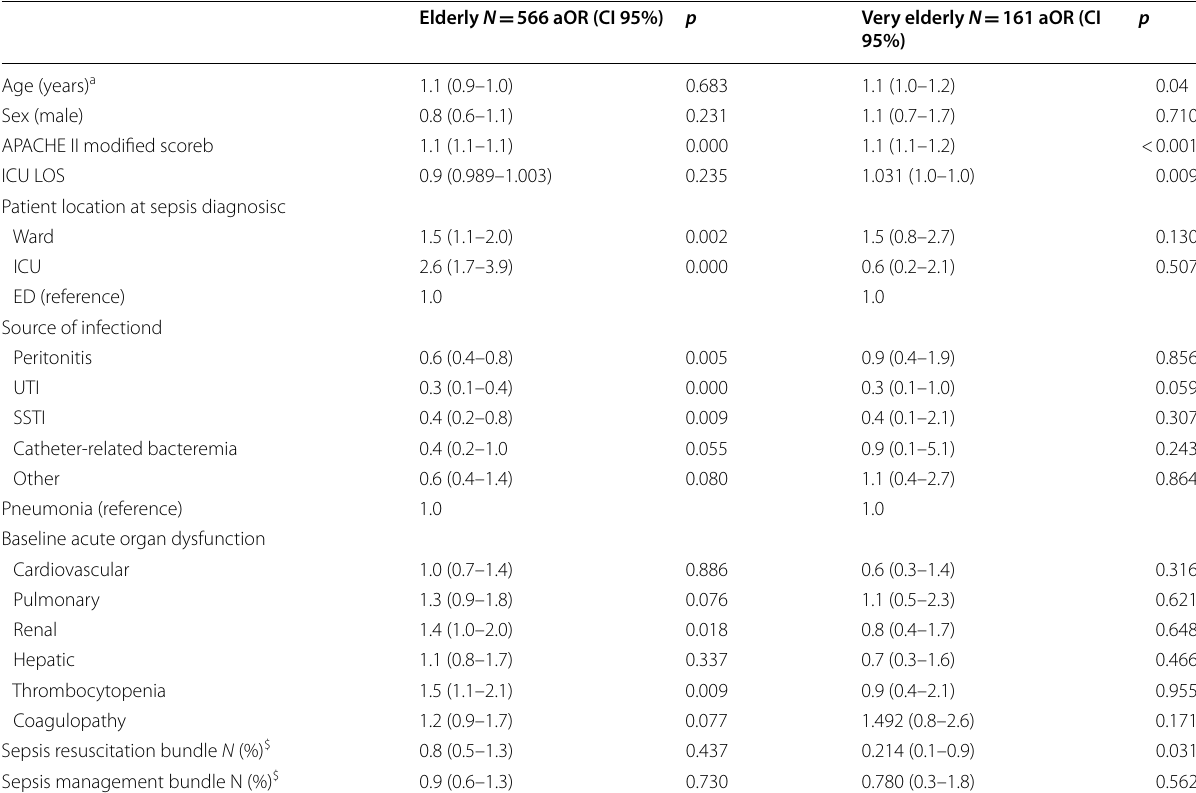
Table 3 Multivariate analysis for risk factors associated with hospital mortality between elderly and very elderly